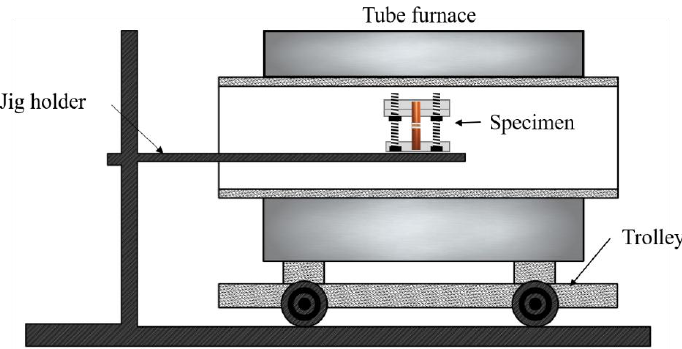
Figure 3. Assembled solder joint at fabricated jig.